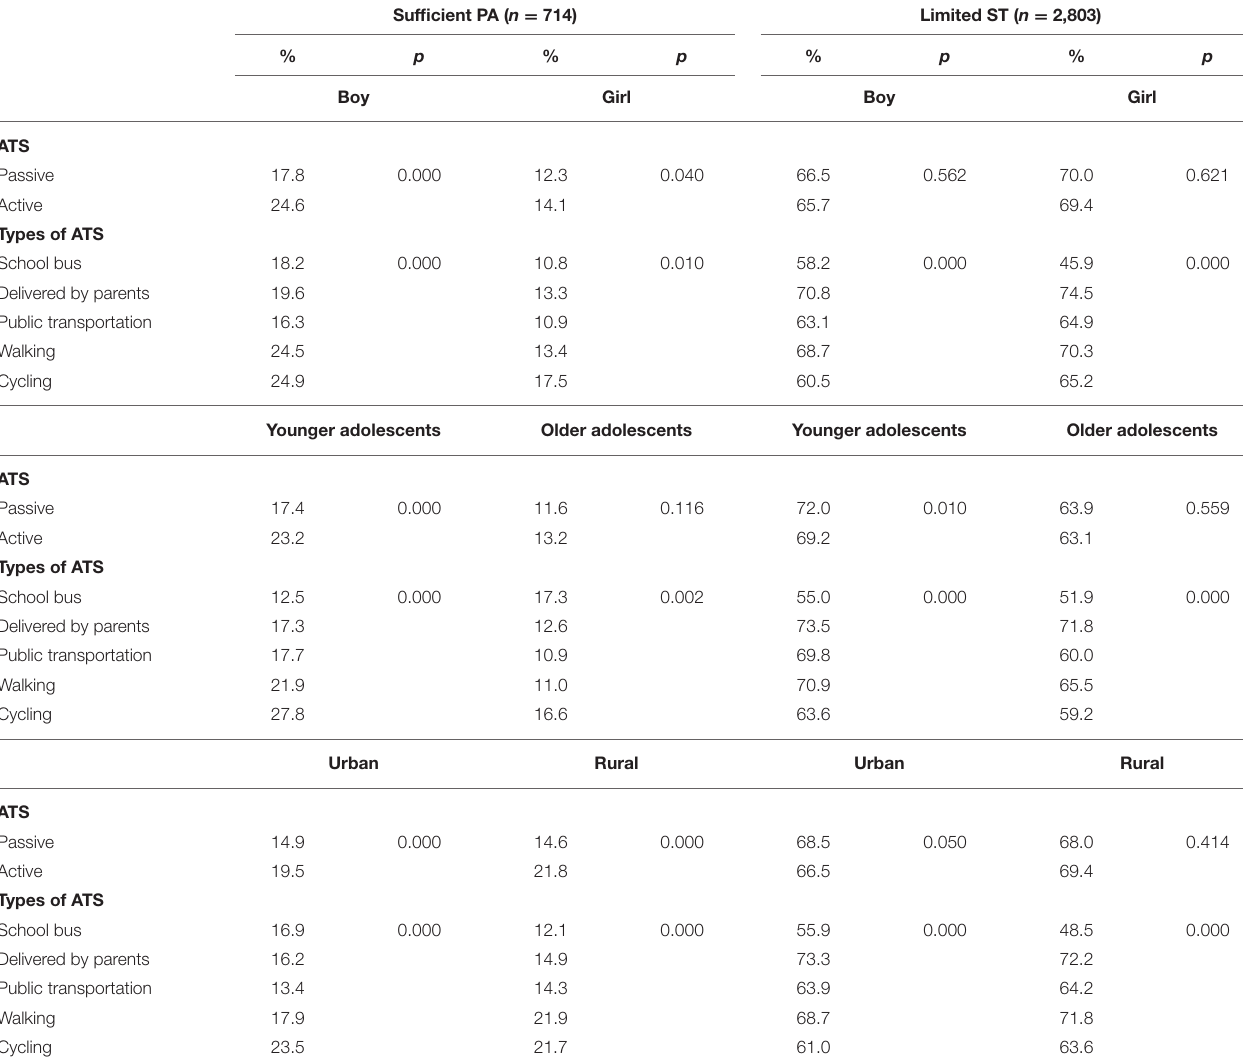
TABLE 3 | Difference of PA and ST by ATS and its types as well as individual characteristics. Sufficient PA ( n =